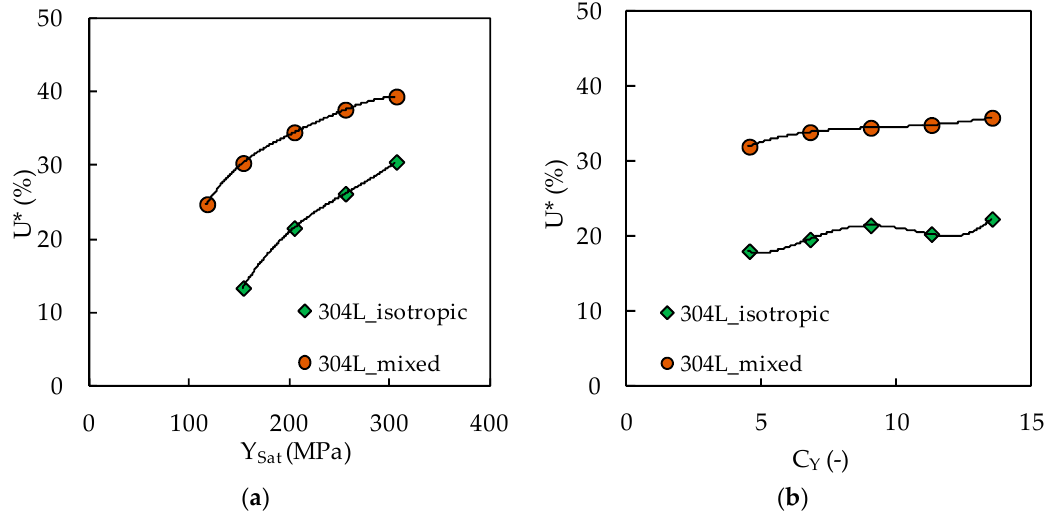
Figure 7. Crack closure level, U * , vs. ( a ) isotropic saturation stress, Y Sat ; ( b ) isotropic saturation rate, C Y (with crack closure).